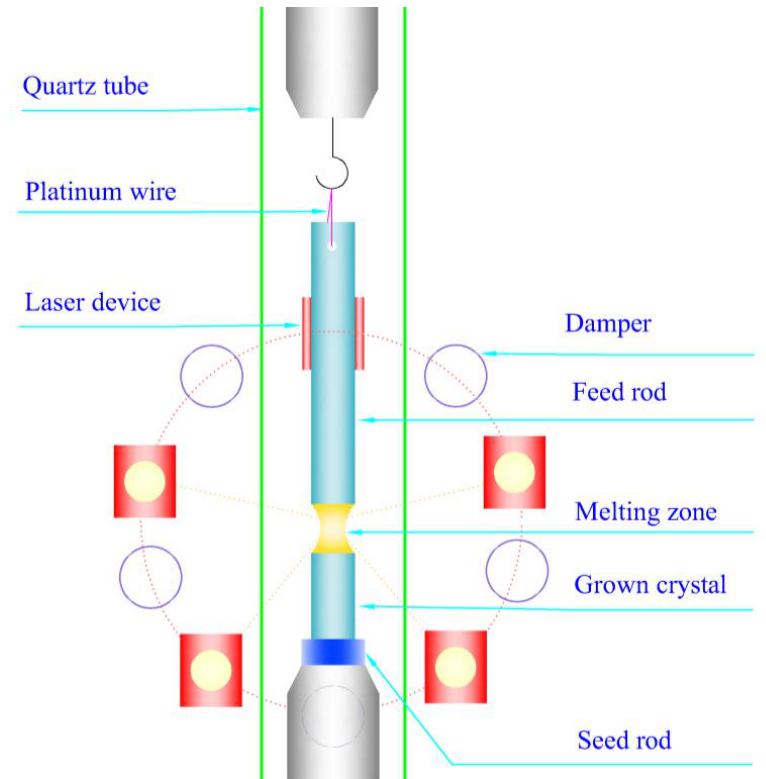
Figure 1. Schematic diagram of the growth principle.